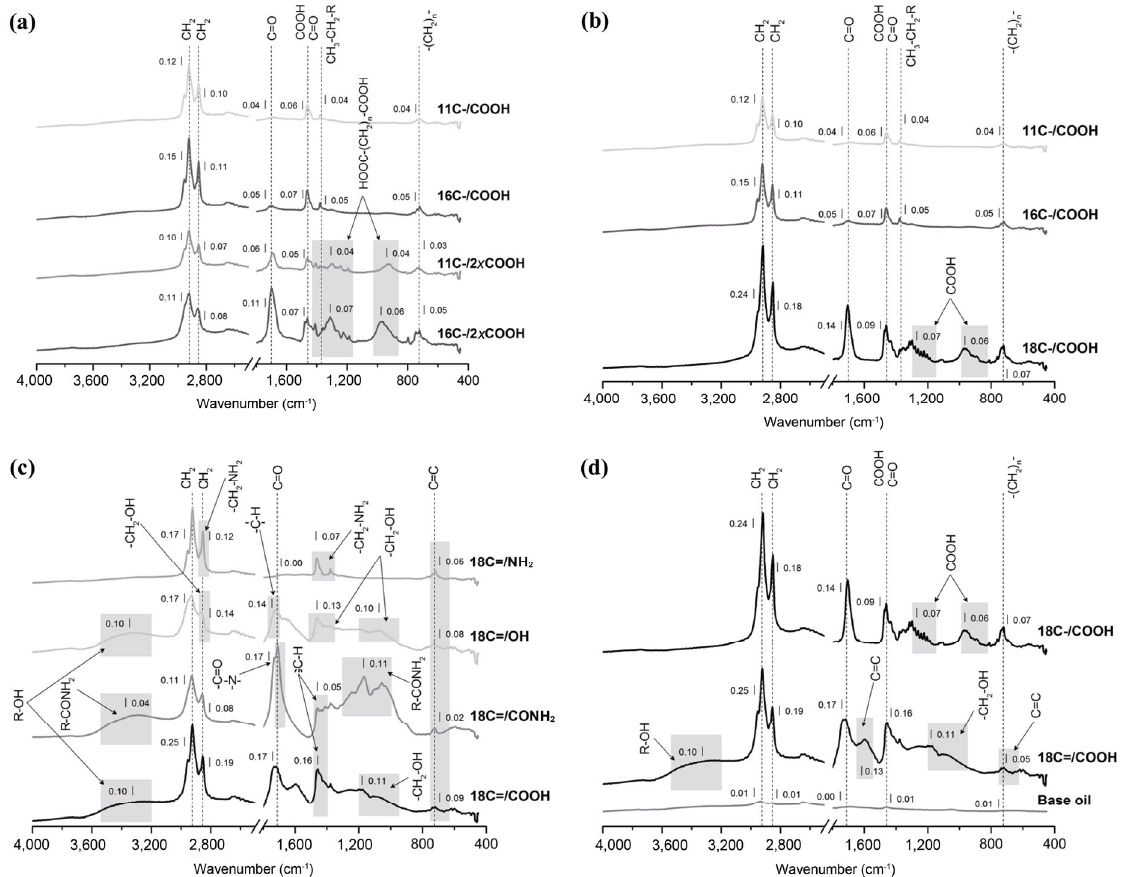
Fig. 6 ATR-FTIR spectra of steel discs after tribological tests at 100 ℃ with base oil and base oil with additives having different (a) numbers of COOH groups; (b) chain lengths; (c) polarities of functional groups; and (d) saturations. shows only three low-intensity peaks (~0.01